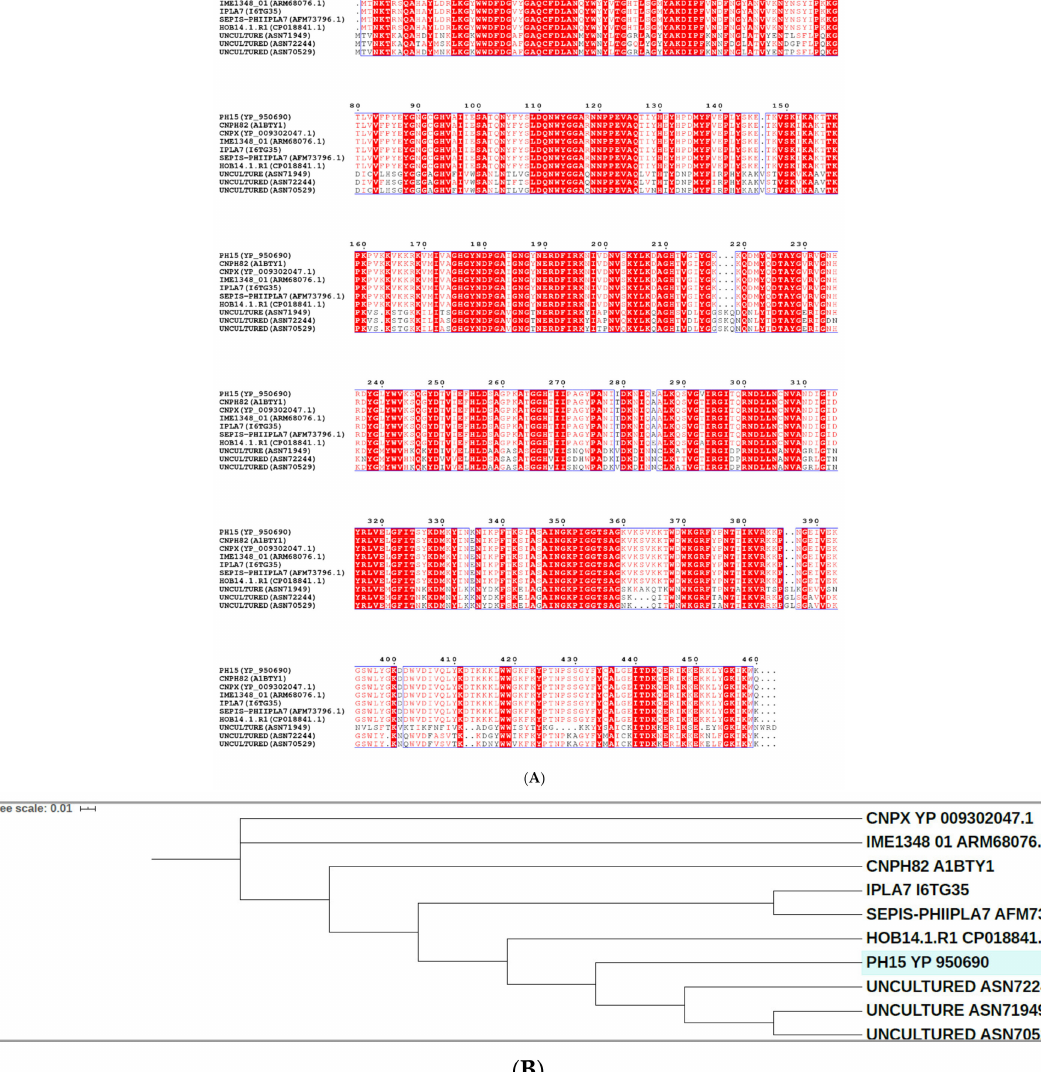
Figure 3. ( A ). Amino acid sequence alignements of endolysin Ph28 with other putative endolysin sequences from Staphylococcus viruses that infect S. epidermidis strains. The alignments were produced using Clustal Omega [26]. Conserved areas are shown shaded. A column is framed, if more than 70% of its residues are similar according to physico-chemical properties. ( B ). Phylogenetic analysis of endolysin Ph28. Phylogenetic tree was constructed by Neighbour-Joining method using the iTOL programme [27]. The tree was formed after alignment of the protein sequences using Clustal Omega [26]. The endolysin sequences were derived from: Staphylococcus virus CNPH82 (NCBI accession number A1BTY1), Staphylococcus virus IPLA7 (NCBI accession number I6TG35), Staphylococcus phage CNPx (NCBI accession number YP_009302047.1), Staphylococcus phage vB_SepiS-phiIPLA7 (AFM73796.1), Staphylococcus phage IME1348_(NCBI accession number ARM68076.1), uncultured Caudovirales phage (NCBI accession number ASN72244), uncultured Caudovirales phage (NCBI accession number ASN70529), uncultured Caudovirales phage (NCBI accession number ASN71949), Staphylococcus phage HOB 14.1.R1 (NCBI accession number